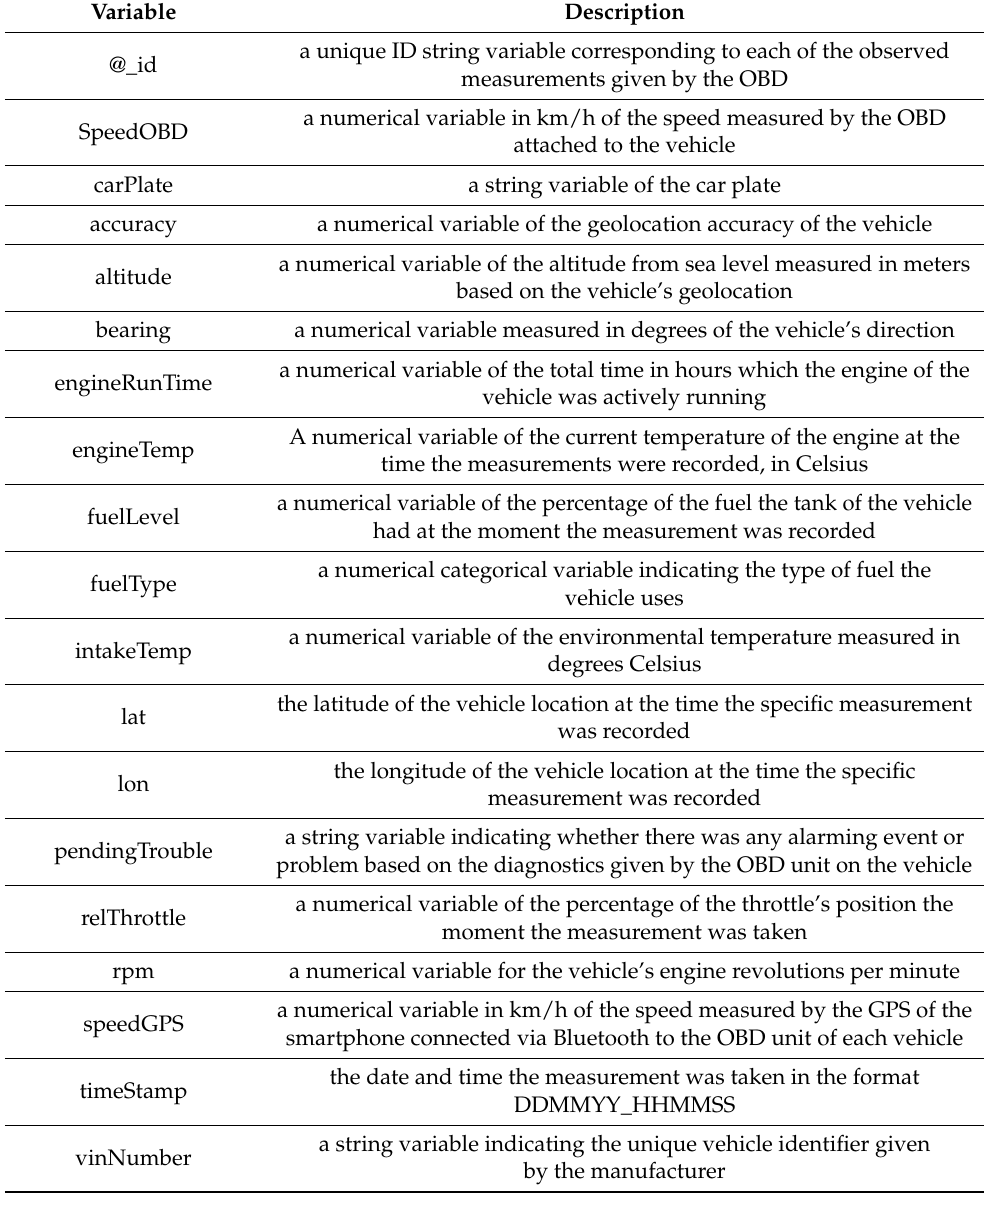
Table 1. Description of